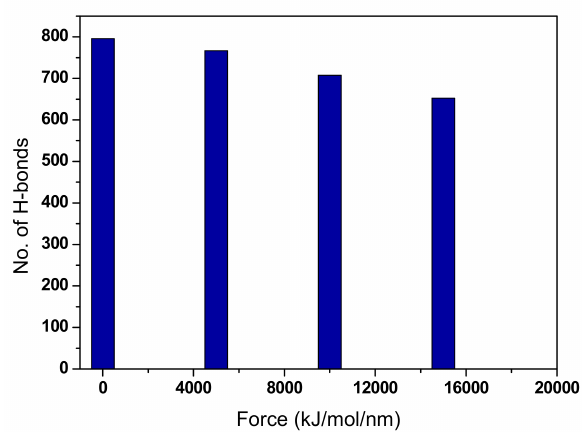
Figure 7. ( a ) Donor-acceptor criterion applied on Case A, and ( b ) H-bonds phenomenon of each chain in with water.